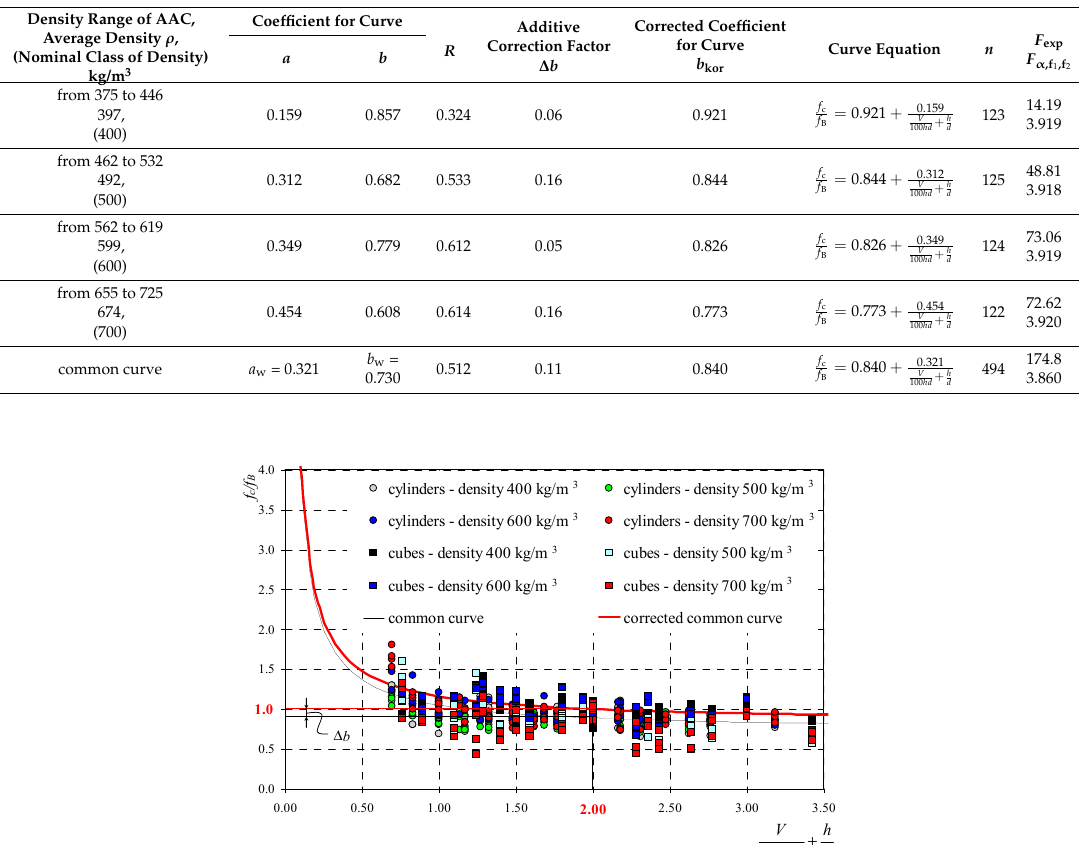
Table 4. Comparison of coefficients and equations of empirical curves.